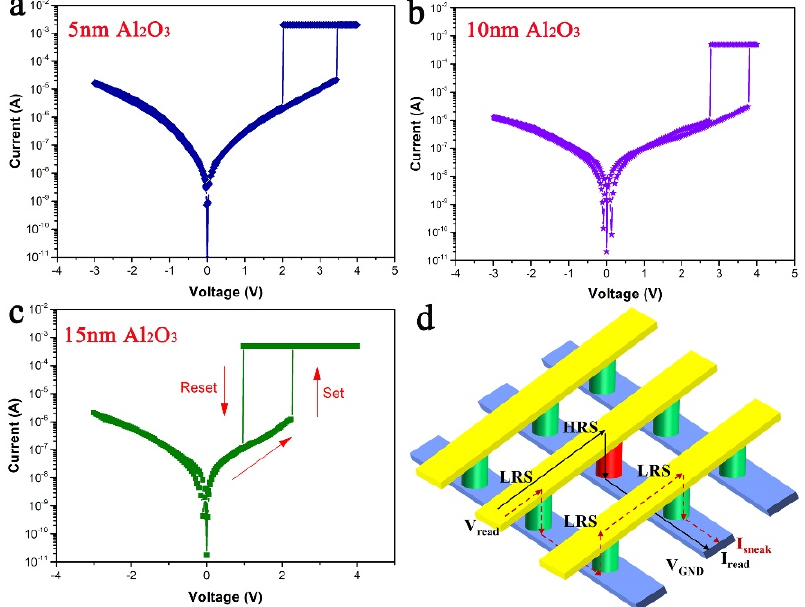
Figure 4. The negative bias-suppressed CRS characteristic of devices with 5 nm ( a ), 10 nm ( b ) and 15 nm ( c ) Al 2 O 3 . The sneak path current problem in the crossbar array ( d ).